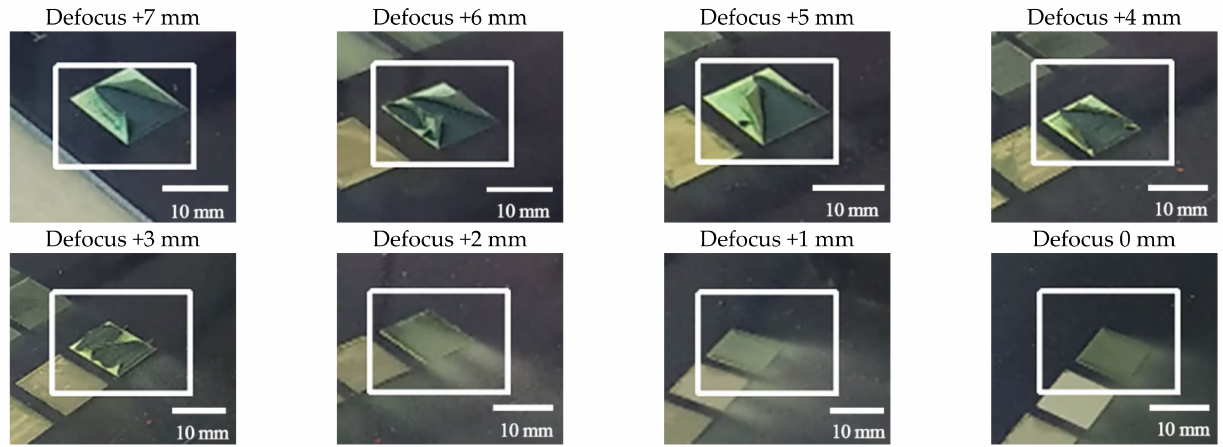
Figure 7. Photos of the samples after laser scanning once in ambient air when defocus distances were 0–+7